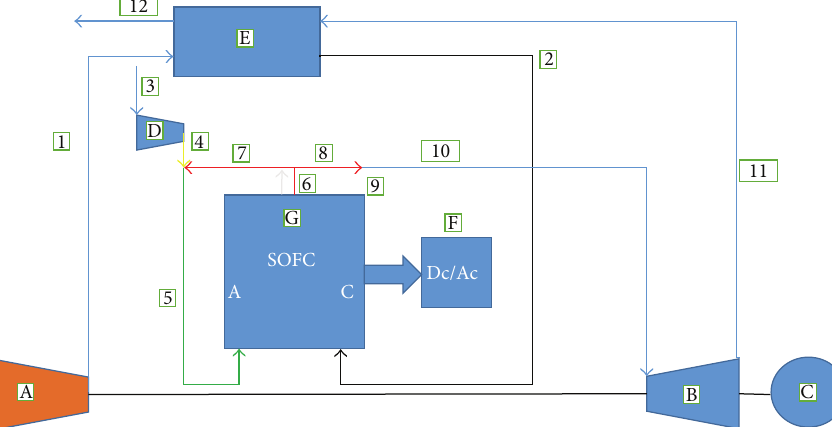
Figure 1: Technical scheme of the base system.